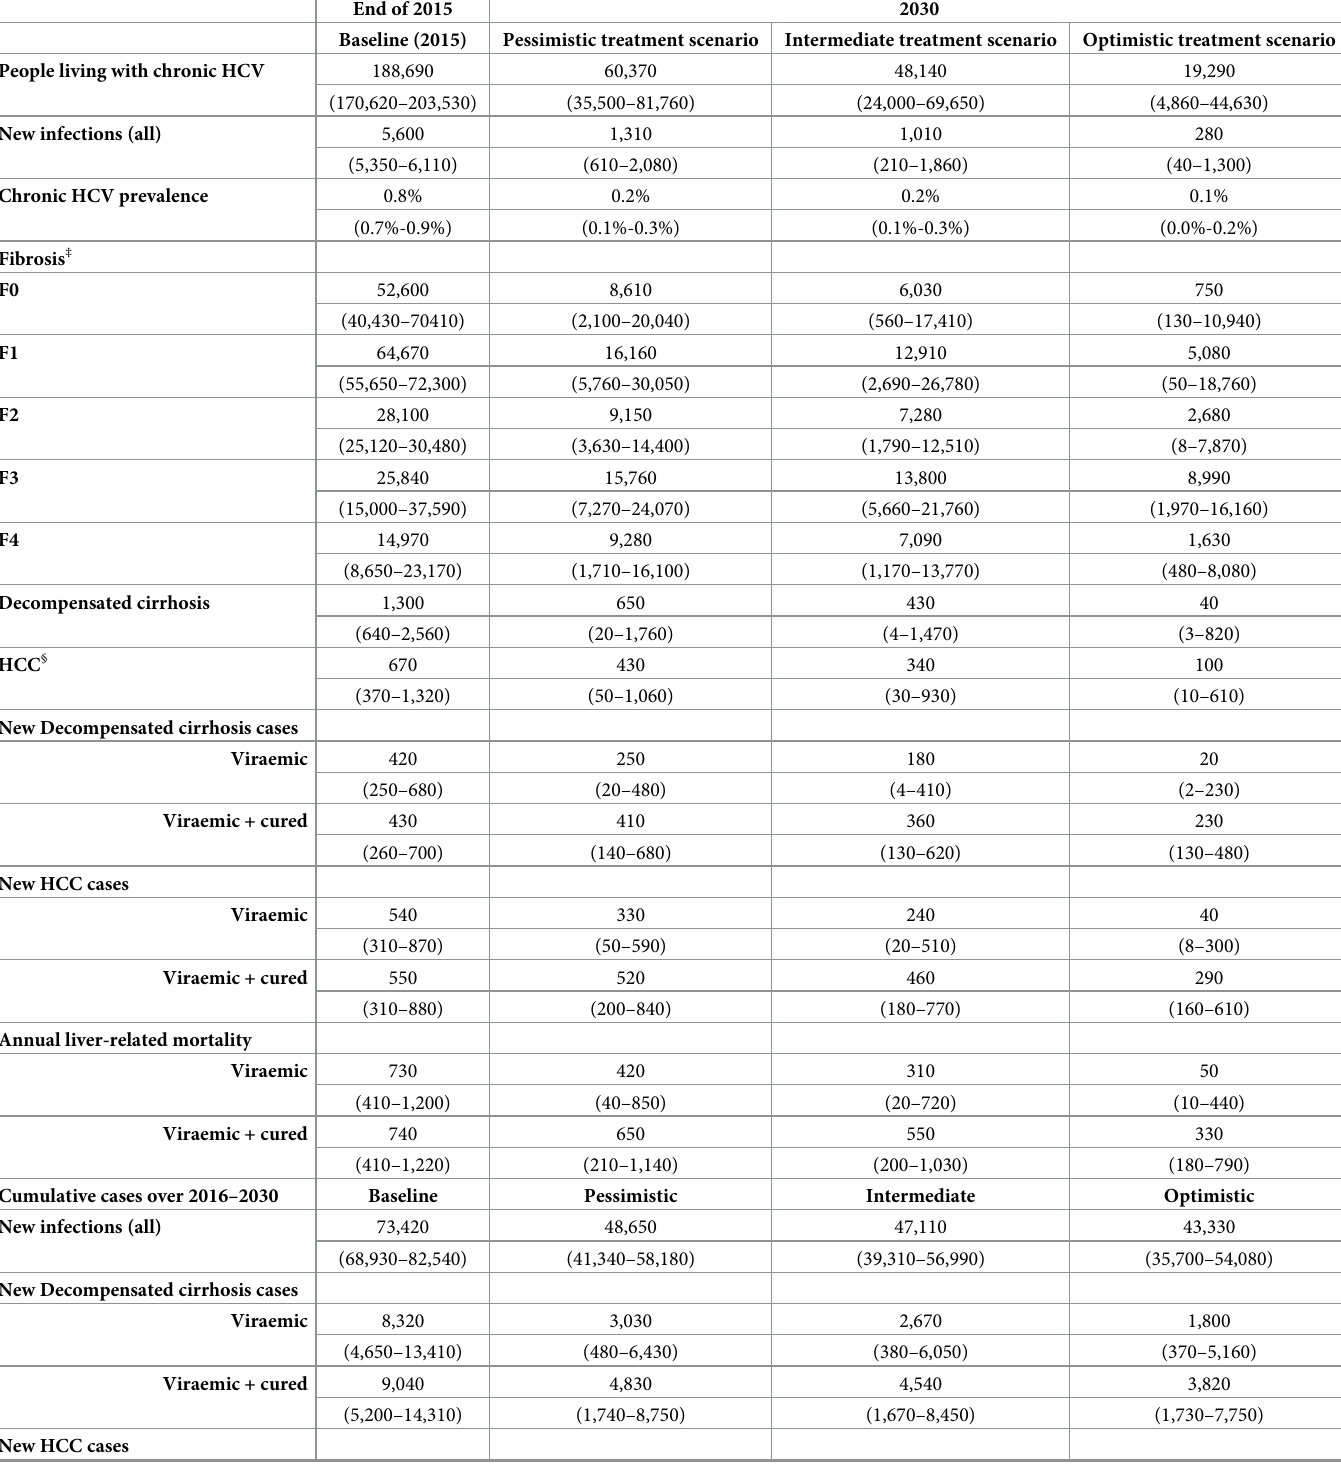
Table 2. The key HCV estimates with treatment roll-out scenarios (best estimate, 95% CI †